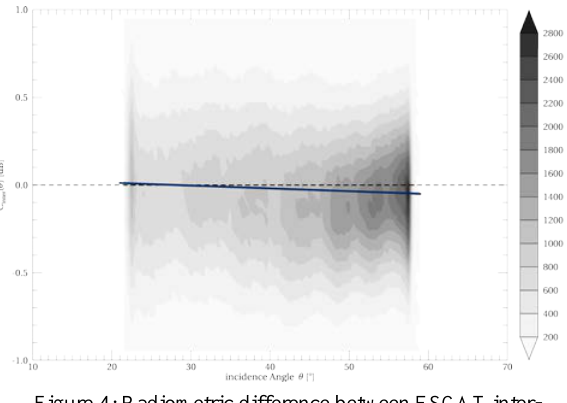
Figure 4: Radiometric difference between ESCAT inter- calibrated backscatter observations and ASCAT